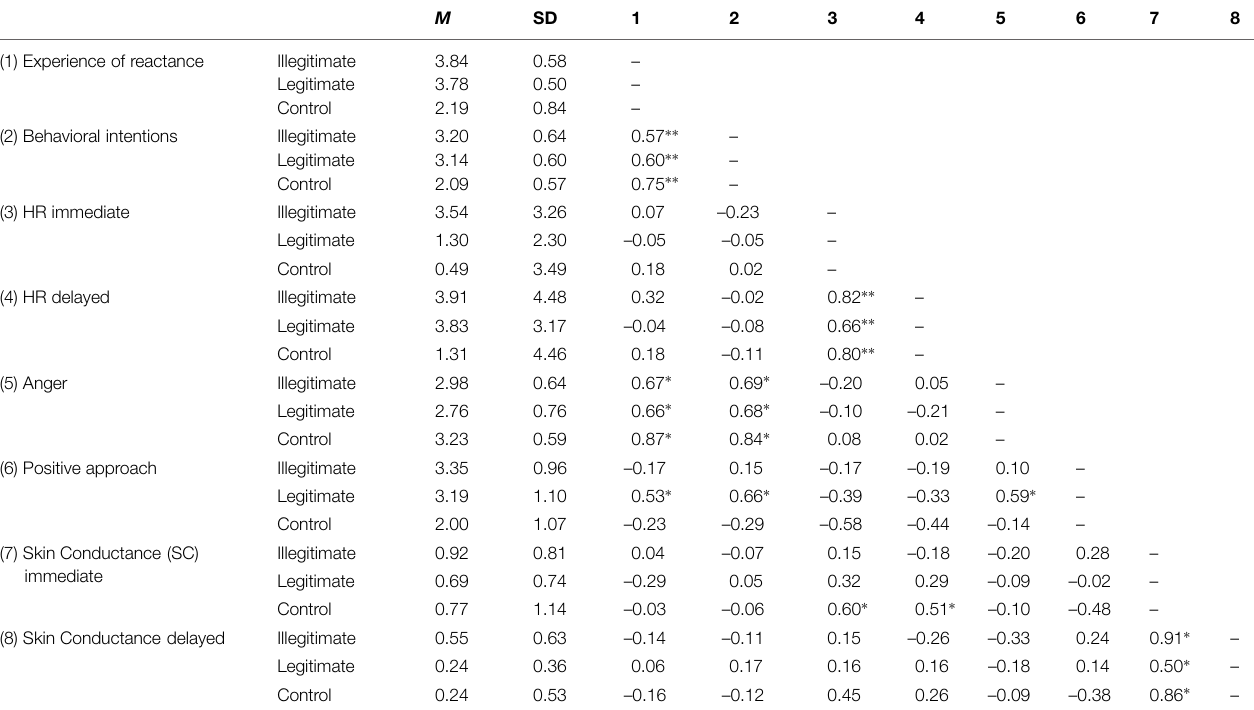
TABLE 2 | Mean and SD and correlation for all dependent variables in the different groups.